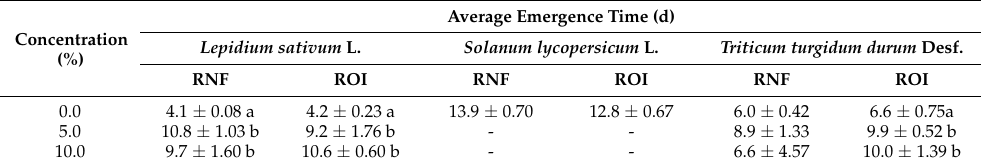
Table 7. Average emergence time of cress, tomato, and durum wheat in response to different concentration of retentates